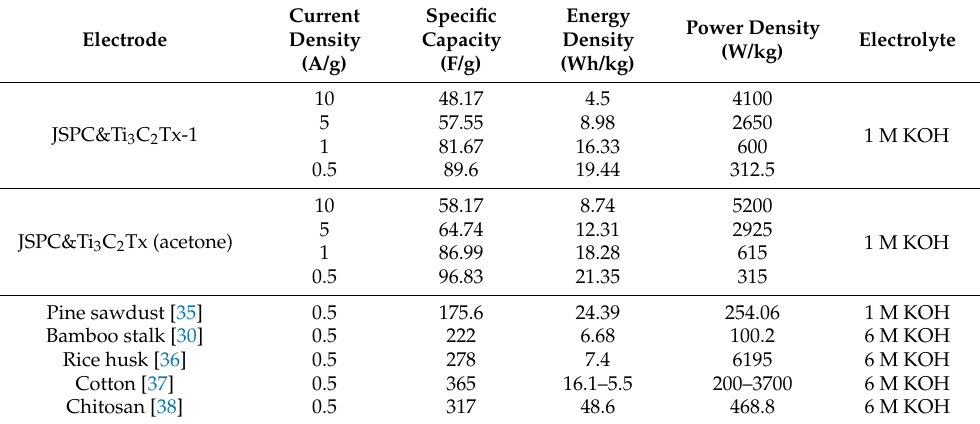
Table 2. The mass-specific capacitance, energy density, and power density of the composite at different current